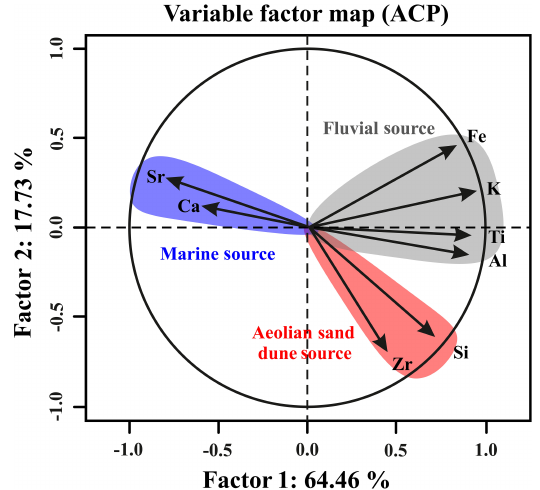
Figure 8. Principal component analysis (PCA) loadings plot of major and trace element concentrations displaying the three main sources: marine, fluvial and aeolian sand dune.